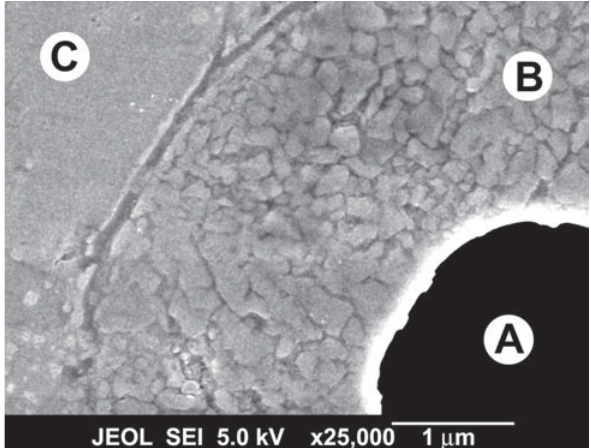
Figure 4. FEG-SEM in transversal polished fiber completely re- acted showing the presence of higher Si content at the channels inside the continuous ceramic phase (dark gray at region B) and between matrix (C) and reacted fiber